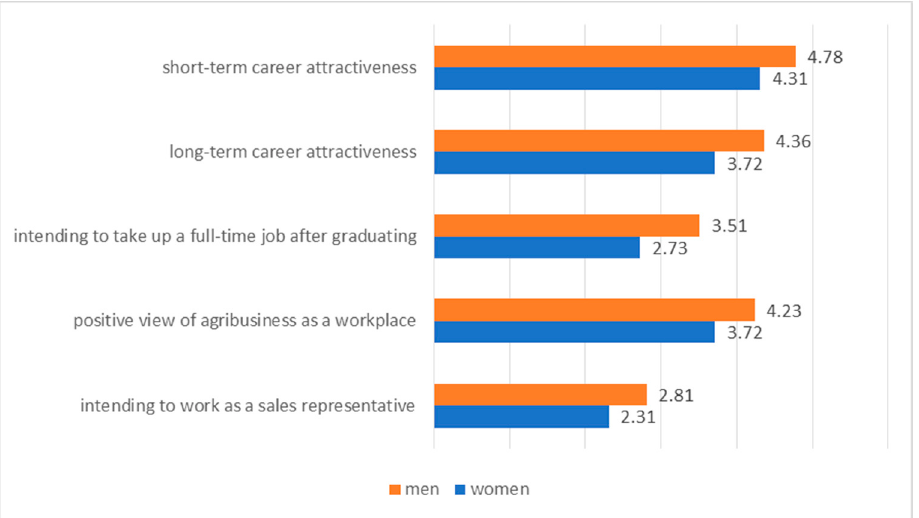
Figure 3. Perceiving agribusiness as a career destination. Source: own research.